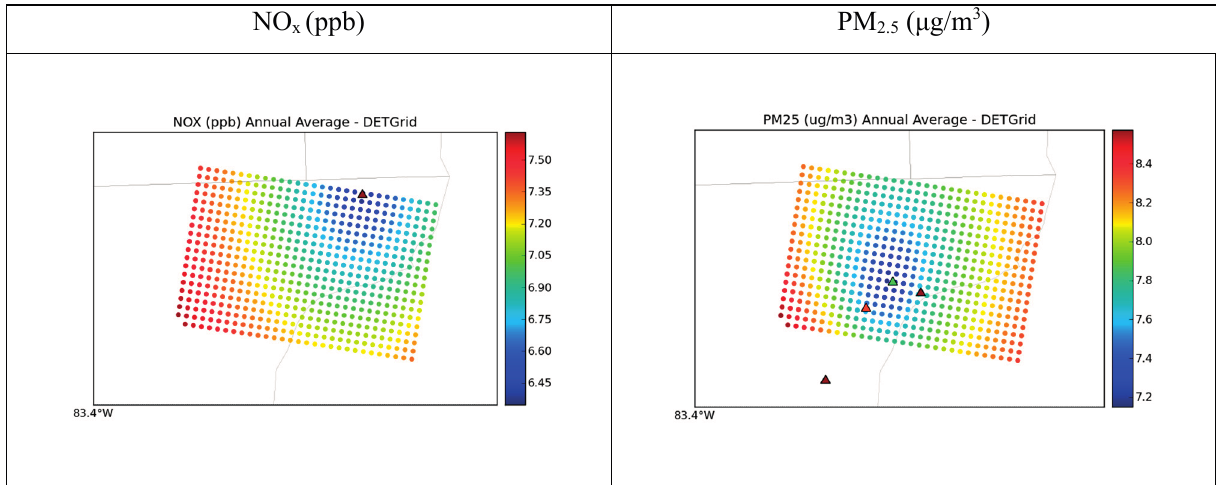
Figure 9. Spatial plots for the Detroit 30-km × 20-km grid showing annual averages of observed concentrations at AQS sites as triangles, and annual background concentration estimates from STOK as circles. Scales were adjusted to the range of background values to portray spatial variability of STOK estimation.